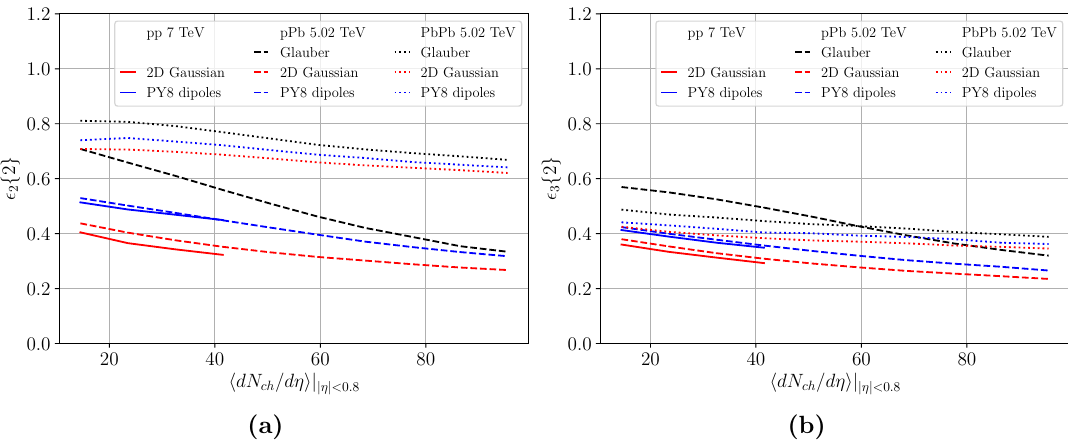
Figure 12. The second (b) and third (c) order eccentricities using two-particle cumulants for pp ; pPb ; PbPb collisions (solid, dashed, dotted, respectively) using the Glauber (black), Gaussian (red) and dipole (blue)